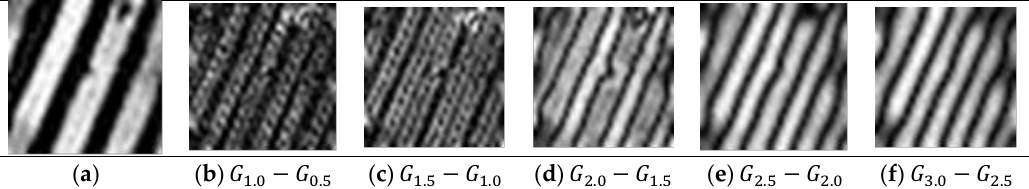
Figure 4. ( a ) Image after enhancement; ( b – f ) Image colored by the absolute value of each DoG layer, which are normalized to the range of